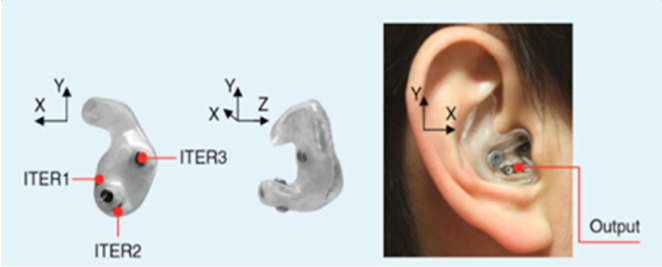
Figure 1. The first in-ear EEG prototype introduced by David Looney et al. in 2012